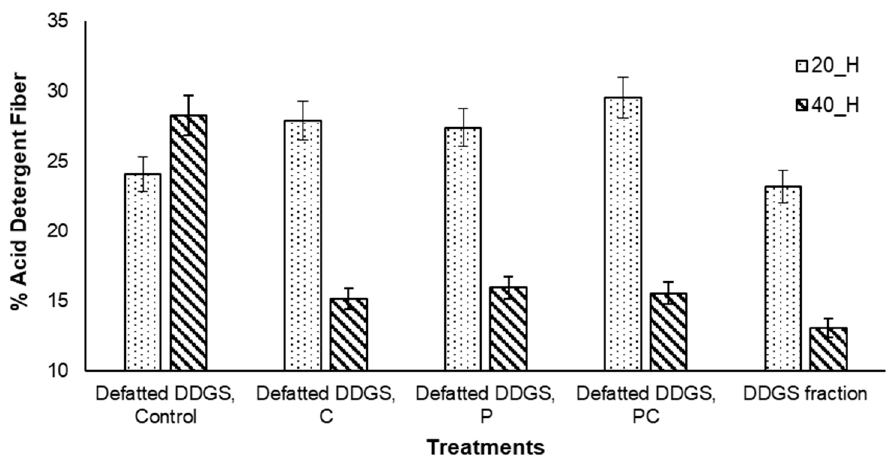
Figure 6. Effects of different enzymes on the NDF variation in defatted DDGS (C—5% cellulase; P— 5% protease; PC—5% protease + 5% cellulase; control: no enzyme; fractions, 20_H: number-20- only) in number-20-sieved aspirated heavy fraction DDGS did improve crude protein sieved aspirated heavy fraction and 40_H: number-40-sieved aspirated heavy fraction). percent of the defatted DDGS.